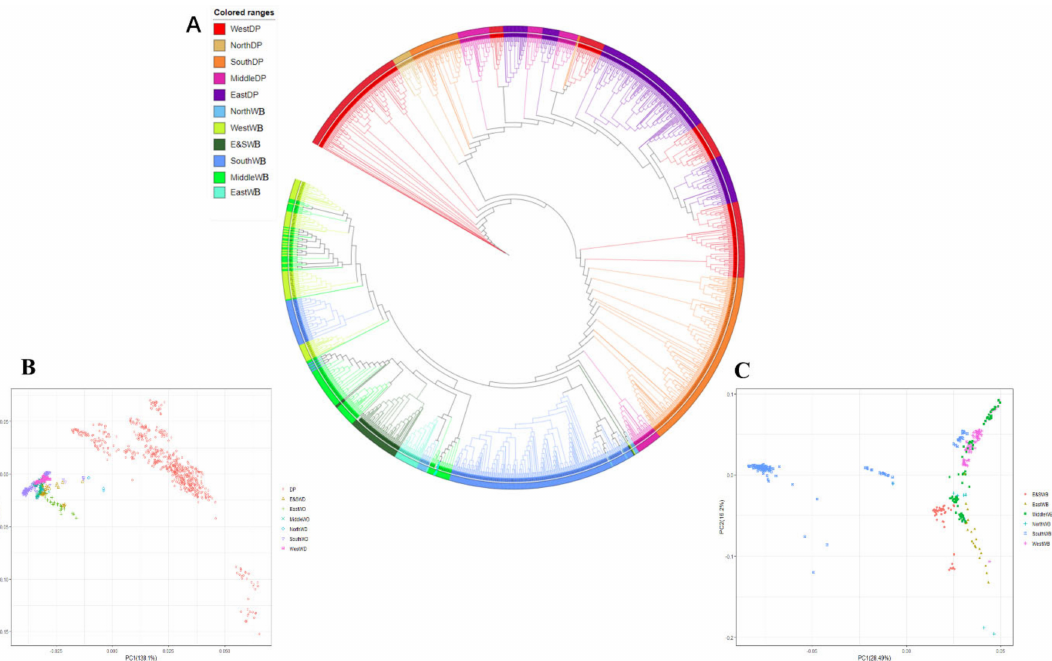
Figure 2. Population genetic network and PCA of European WBs and DPs. ( A ) Classification of the habitat large geographical plate of European WBs and DPs. Each color represents the domestic and WB population in a different area, including WestDP, NorthDP, SouthDP, MiddleDP, EastDP, NorthWB, WestWB, E&SWB, SouthWB, MiddleWB, EastWB, DP and WB, which was divided by regions; ( B ) PCA of the 60K SNP data set: based on all the available data (1098), divided into seven species by region; ( C ) Principal component analysis of the 60K SNPs data set: based on the European WB data divided by six